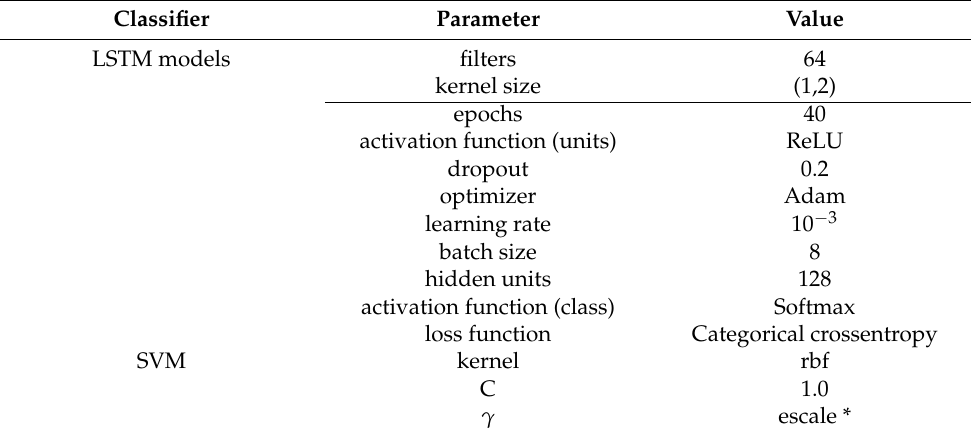
Table 1. Parameters of the classification